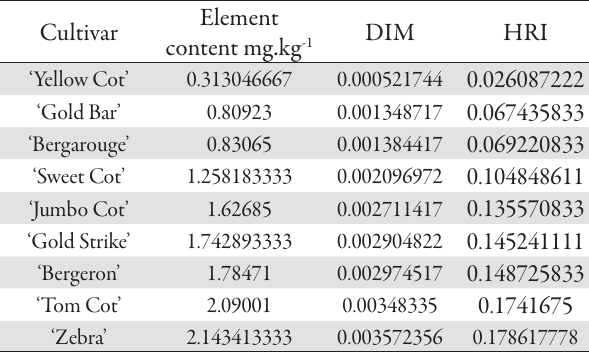
Tab. 2. Health Risk Index (HRI) and Daily Intake of Metals (DIM) calculated for Ni’s content of examined